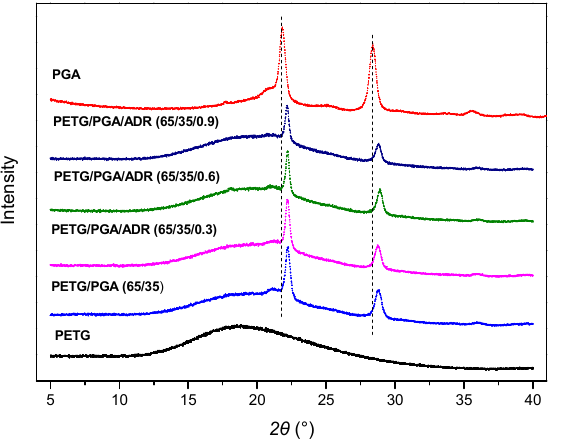
Figure 15. WAXD patterns of neat PETG, PGA, and PETG/PGA/ADR (65/35/x) samples.